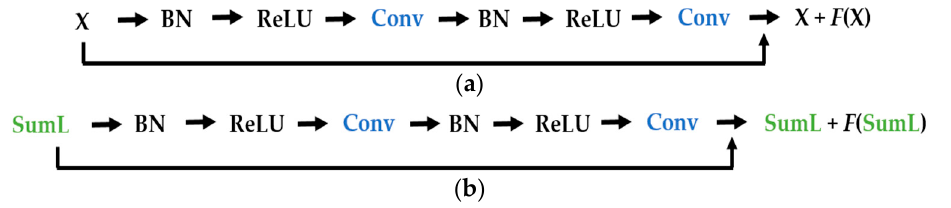
Figure 6. ( a ) Structure of the residual building blocks (1 and 2) in the four different networks; ( b ) Structure of the final residual building block after the summation layer (SumL).